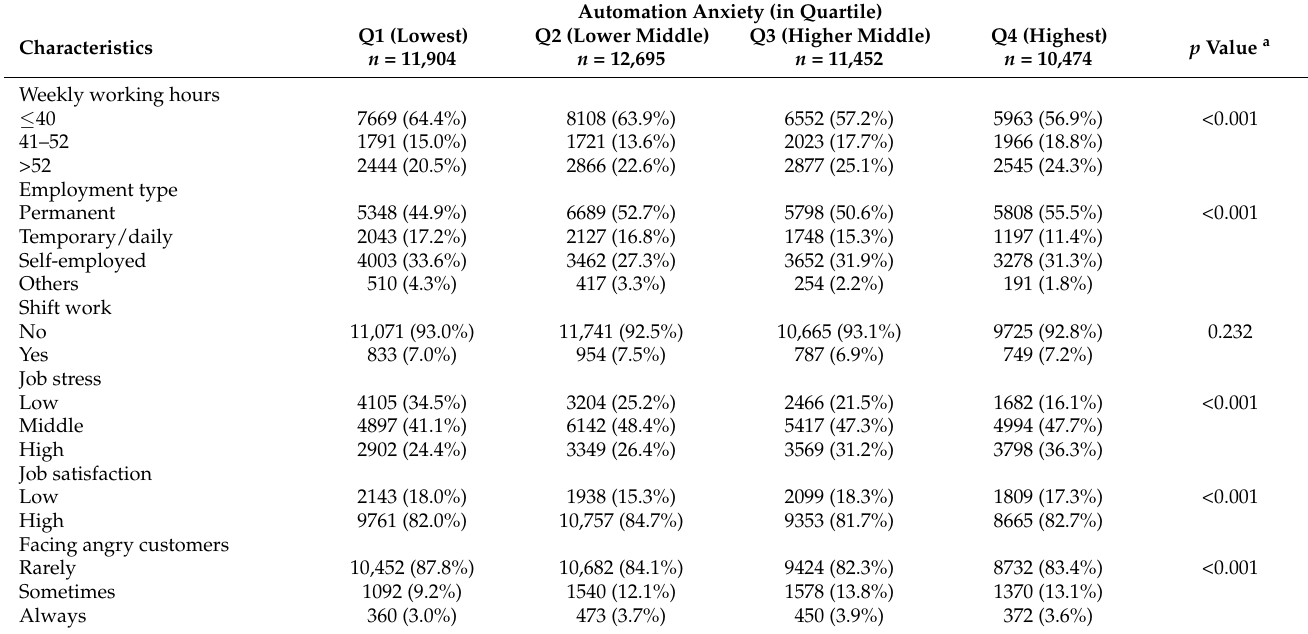
Automation Anxiety (in Quartile)